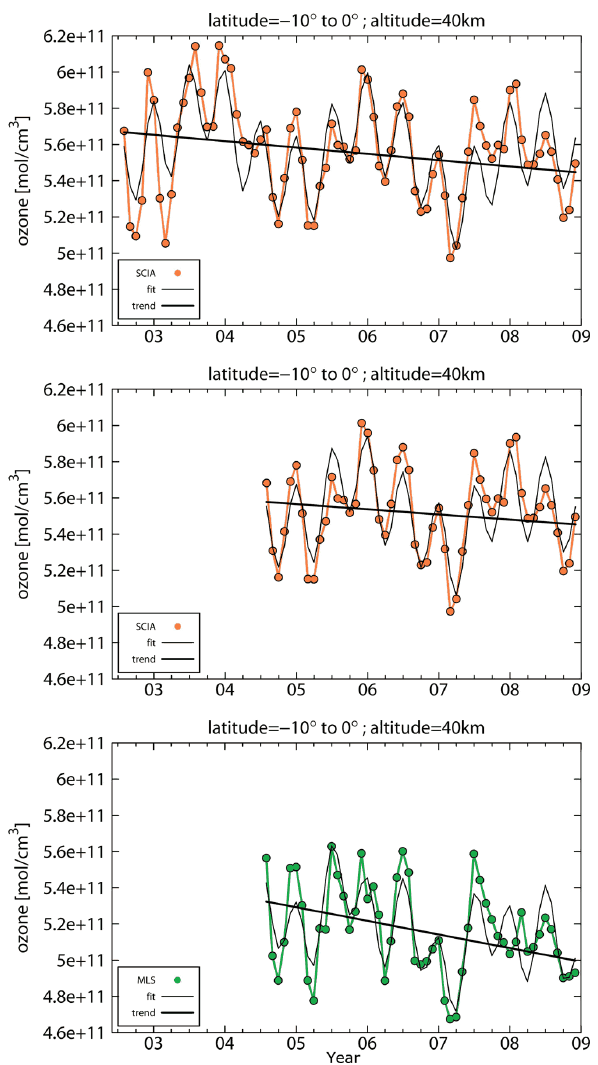
Fig. 8. SCIAMACHY (orange) and MLS (green) monthly mean ozone timeseries near the equator ( − 10 ◦ to 0 ◦ ) at 40km altitude. (orange) and MLS (green) monthly mean ozone timeseries near the Fig. 8. SCIAMACHY The black curves represent the complete fit (QBO and linear trend) and the lines depict the linear trends. The linear trend of SCIA- equator (- 10 ◦ to 0 ◦ ) at 40 km altitude. The black curves represent the complete fit (QBO and MACHY ozone over the longer period 2002–2008 (top panel) is linear trend) and the lines depict the linear trends. The linear trend of SCIAMACHY ozone over statistically significant (2 σ ), while both MLS and SCIAMACHY trends for the shorter common observation period 2004–2008 are the longer period 2002-2008 (top panel) is statistically significant (2 σ ), while both MLS and insignificant (middle and bottom SCIAMACHY trends for the shorter common observation period 2004-2008 are insignificant (bottom two panels). 38